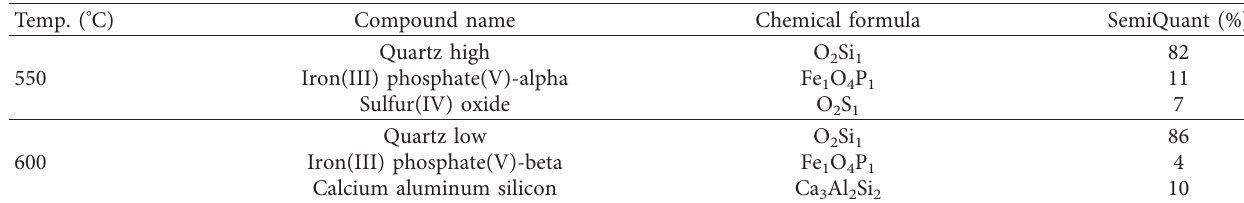
Table 9: XRD analysis of BD-2B